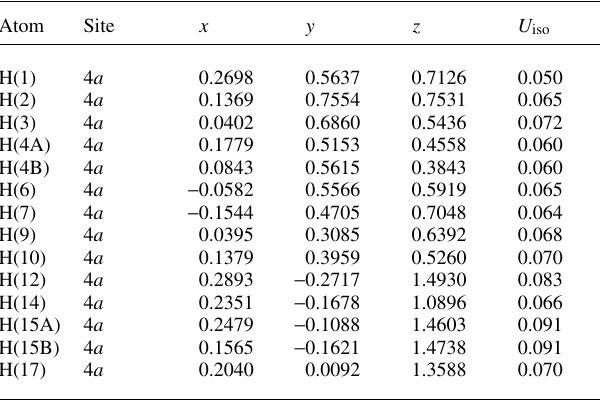
Table 2. Atomic coordinates and displacement parameters (in Å 2 )